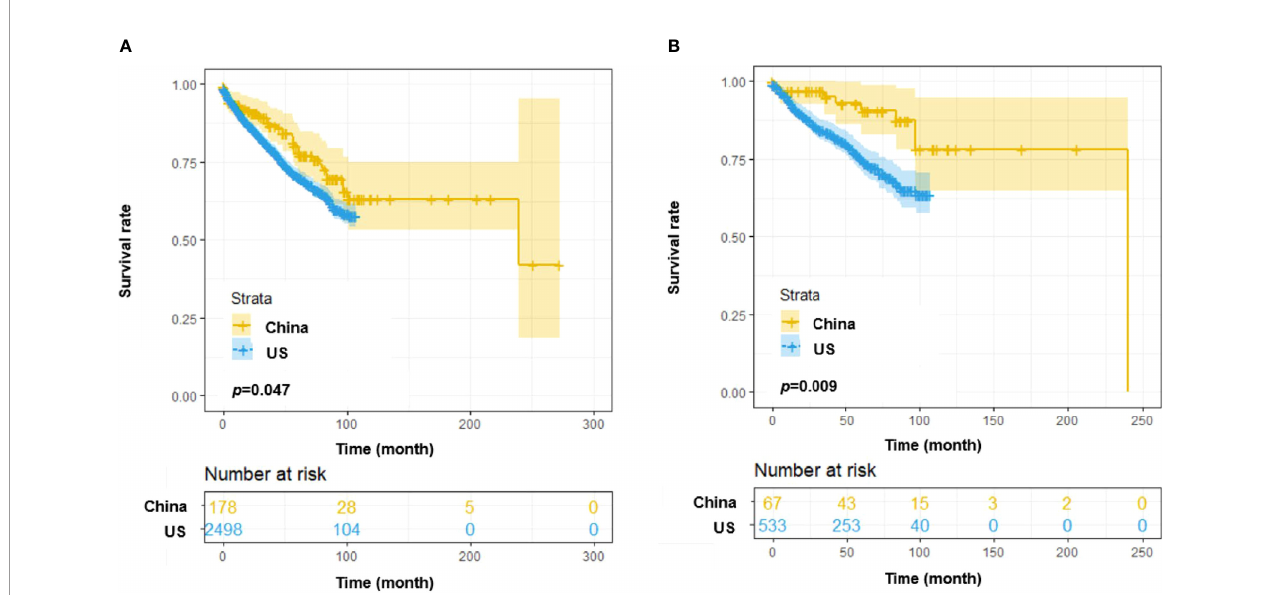
FIGURE 2 | Survival analysis among CLL patients from the US and China. (A) Overall survival (OS) differences among patients from the SEER database and the Chinese SPHCLL database. (B) OS differences among young (<60 years old) patients from the SEER database and the Chinese SPHCLL database.